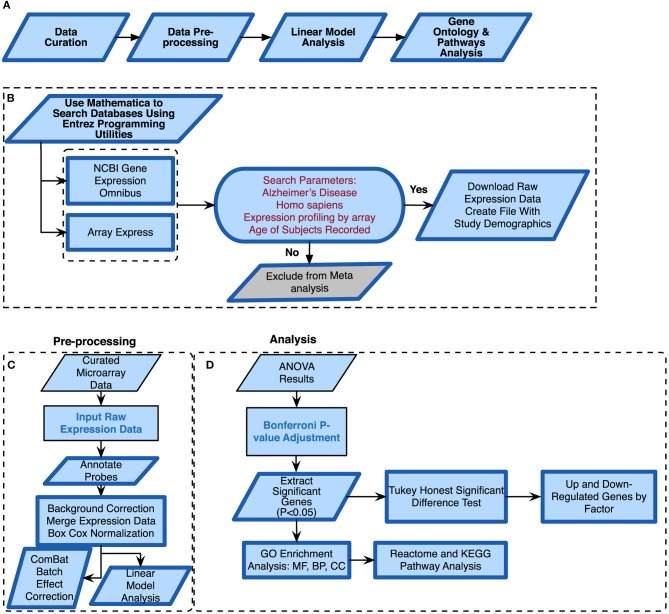
Alzheimer's disease meta-analysis framework. (A) Simplified workflow used for the meta-analysis, (B) pipeline for curating microarray data, (C) pipeline for pre-processing the microarray data, (D) methods used for meta-analysis of raw expression microarray data.